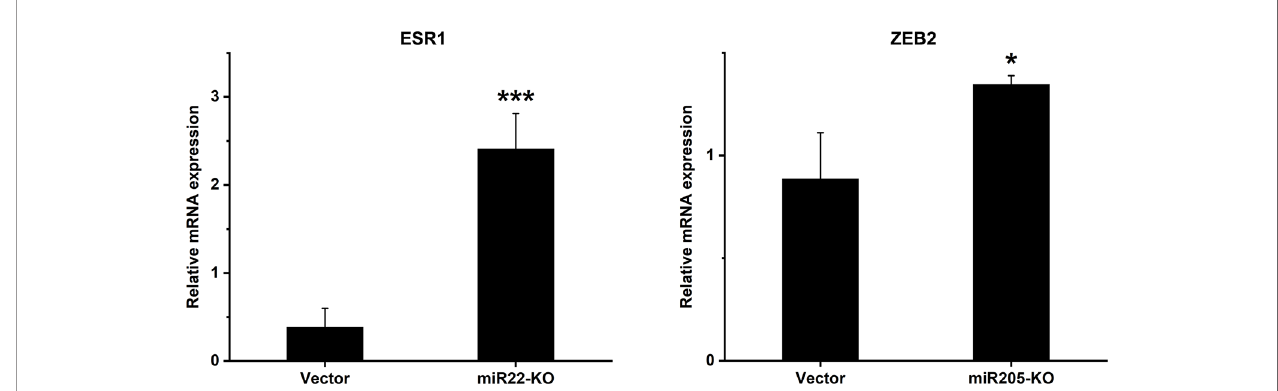
FIGURE 6 | mRNA expression levels of selected genes after miR-knockout. Expression levels of ESR1 in miR22-KO and ZEB2 in miR205-KO cell lines were analysed using qRT-PCR. The relative mRNA levels are shown after normalization to GAPDH. ESR1 , Estrogen receptor alpha; ZEB2 , Zinc fi nger E-box binding homeobox 2. Data are presented as means ± SD. *p ≤ 0.05, ***